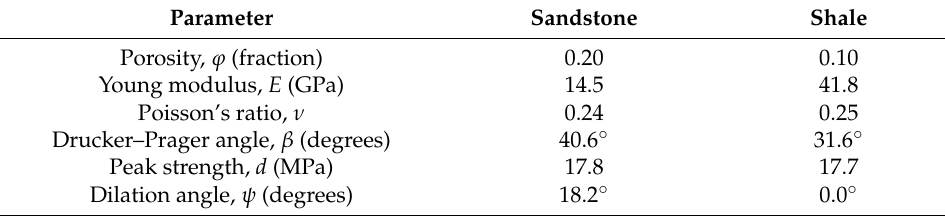
Table 3. Rock properties of the modeled formations based on Markou and Papanastasiou [14]. Parameter Sandstone Shale Porosity, ϕ